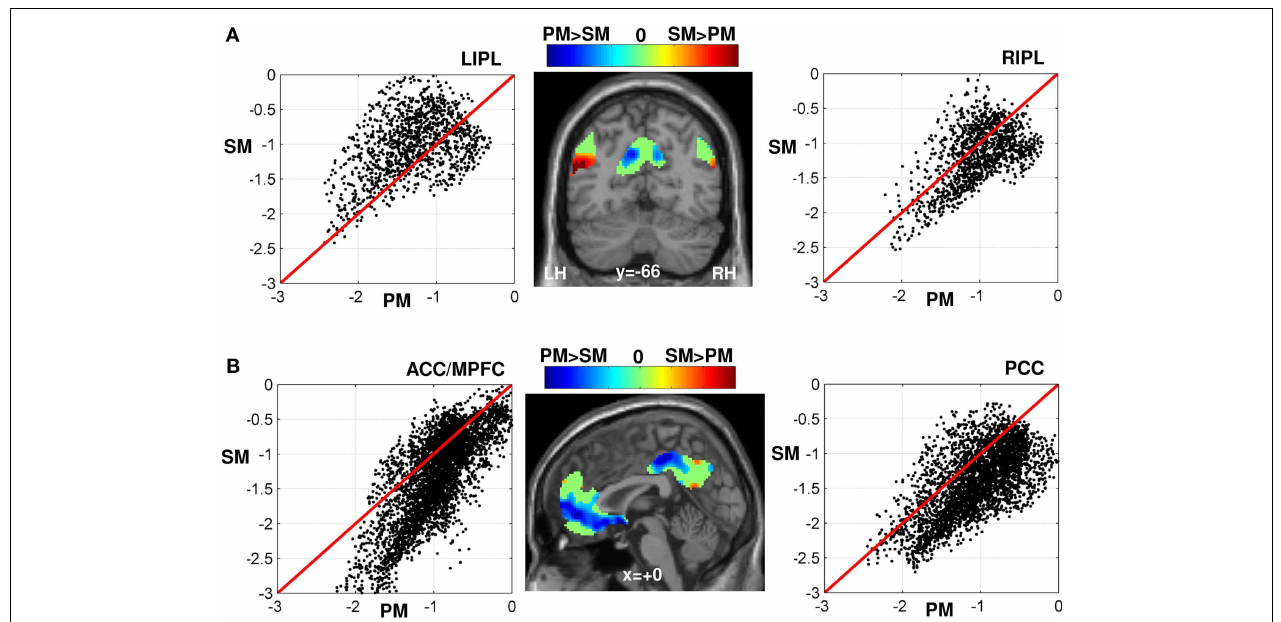
(in blue) during SM than PM, and in green similar deactivation level during both SM and PM. (B) idem as (A) in the midline regions PCC and MPFC (projected on a sagittal view at x = 0).Voxels shown in blue (middle panel) are strongly deactivated during SM than PM (limited to the midline regions of the DMN). For illustration purpose, all voxels with a weak difference in effect size between SM and PM are set to zero in the color-coded scale (green color). SM, semantic matching; PM, perceptual matching; LIPL, left inferior parietal lobule; RIPL, right inferior parietal lobule; ACC/MPFC, anterior cingulate cortex/medial prefrontal cortex; PCC, precuneus and posterior cingulate cortex; LH, left hemisphere; RH, right hemisphere.The effects that were significant at p < 0.05 FWE-corrected are visualized in Figures 2A and 4